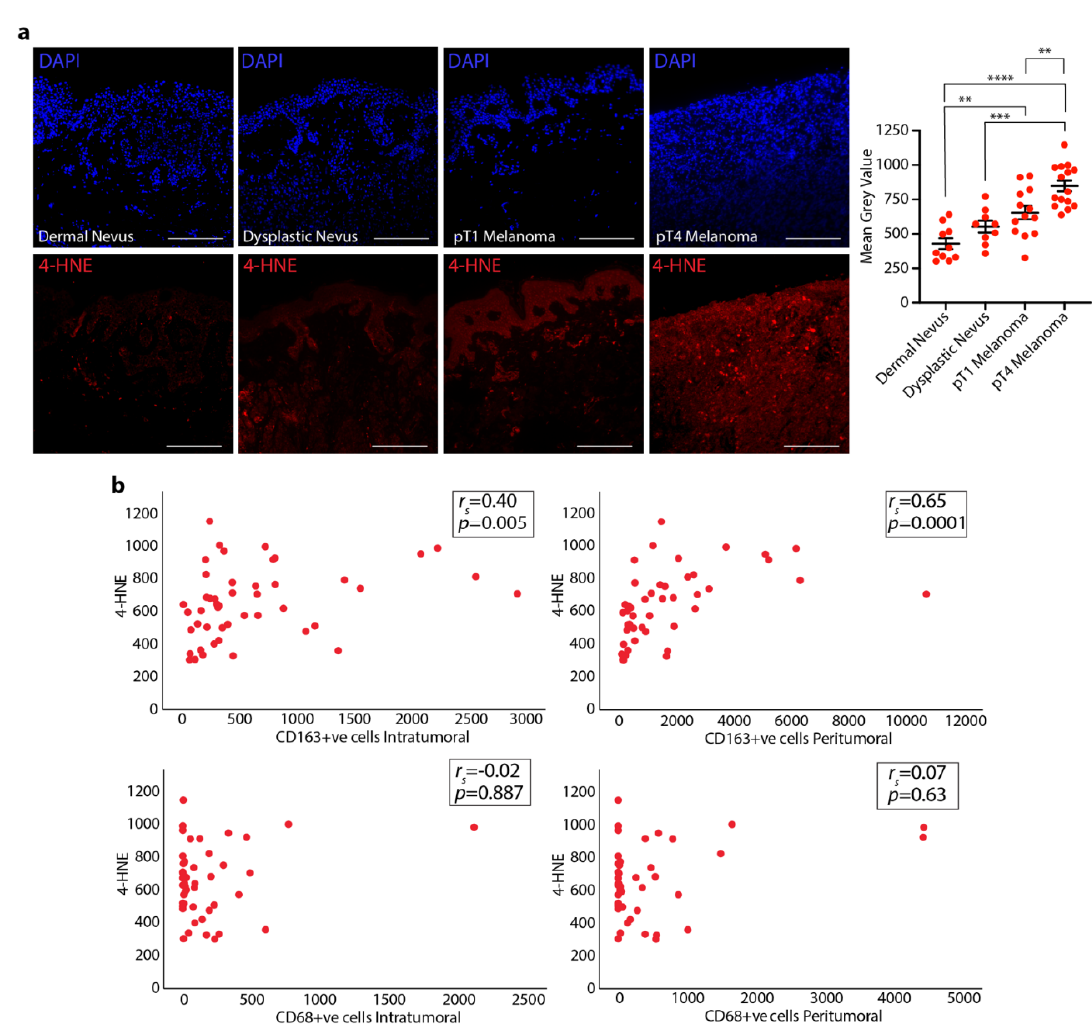
Figure 2. 4-HNE expression in dermal and dysplastic nevi and melanoma tissues and its correlation with TAMs. ( a ) Representative images and pooled data of 4-HNE staining in dermal and dysplastic nevus and pT1 and pT4 melanoma tissues. DAPI is the nuclear counterstaining. ( b ) Scatter plot reporting Spearman’s correlation between 4-HNE and intratumoral and peritumoral CD68+ve or CD163+ve cells. Scale bar 250 μ m. ** p < 0.01, *** p < 0.001, **** p < 0.0001, one-way ANOVA and Bonferroni post hoc test.